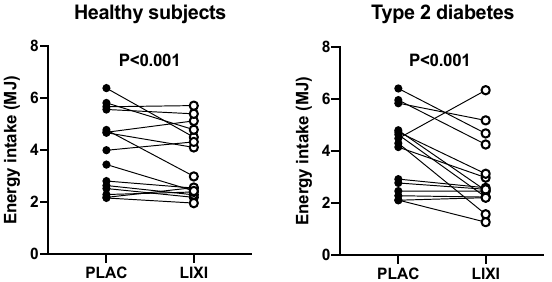
Figure 2. E ff ect of lixisenatide (10 mcg sc) (open circles) vs. placebo (sc) (black circles) on energy intake (MJ) at a bu ff et-style meal in healthy participants and patients with T2D p < 0.001 for both (placebo vs. lixisenatide). p < 0.001 treatment di ff erence in two-way repeated measures analysis of variance (ANOVA). Treatment-by-group interaction nonsignificant ( p > 0.05).